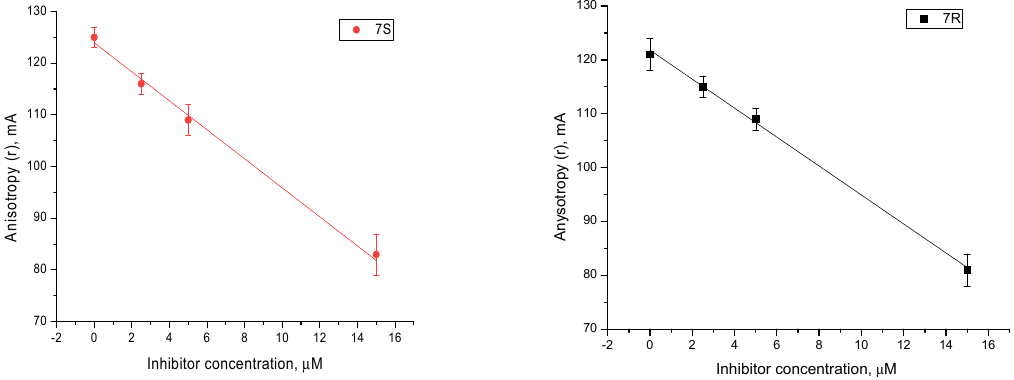
Figure 2. Fluorescence anisotropy assay: a change in the value of fluorescence anisotropy in the presence of compounds 7S ( left ) and 7R ( right ).